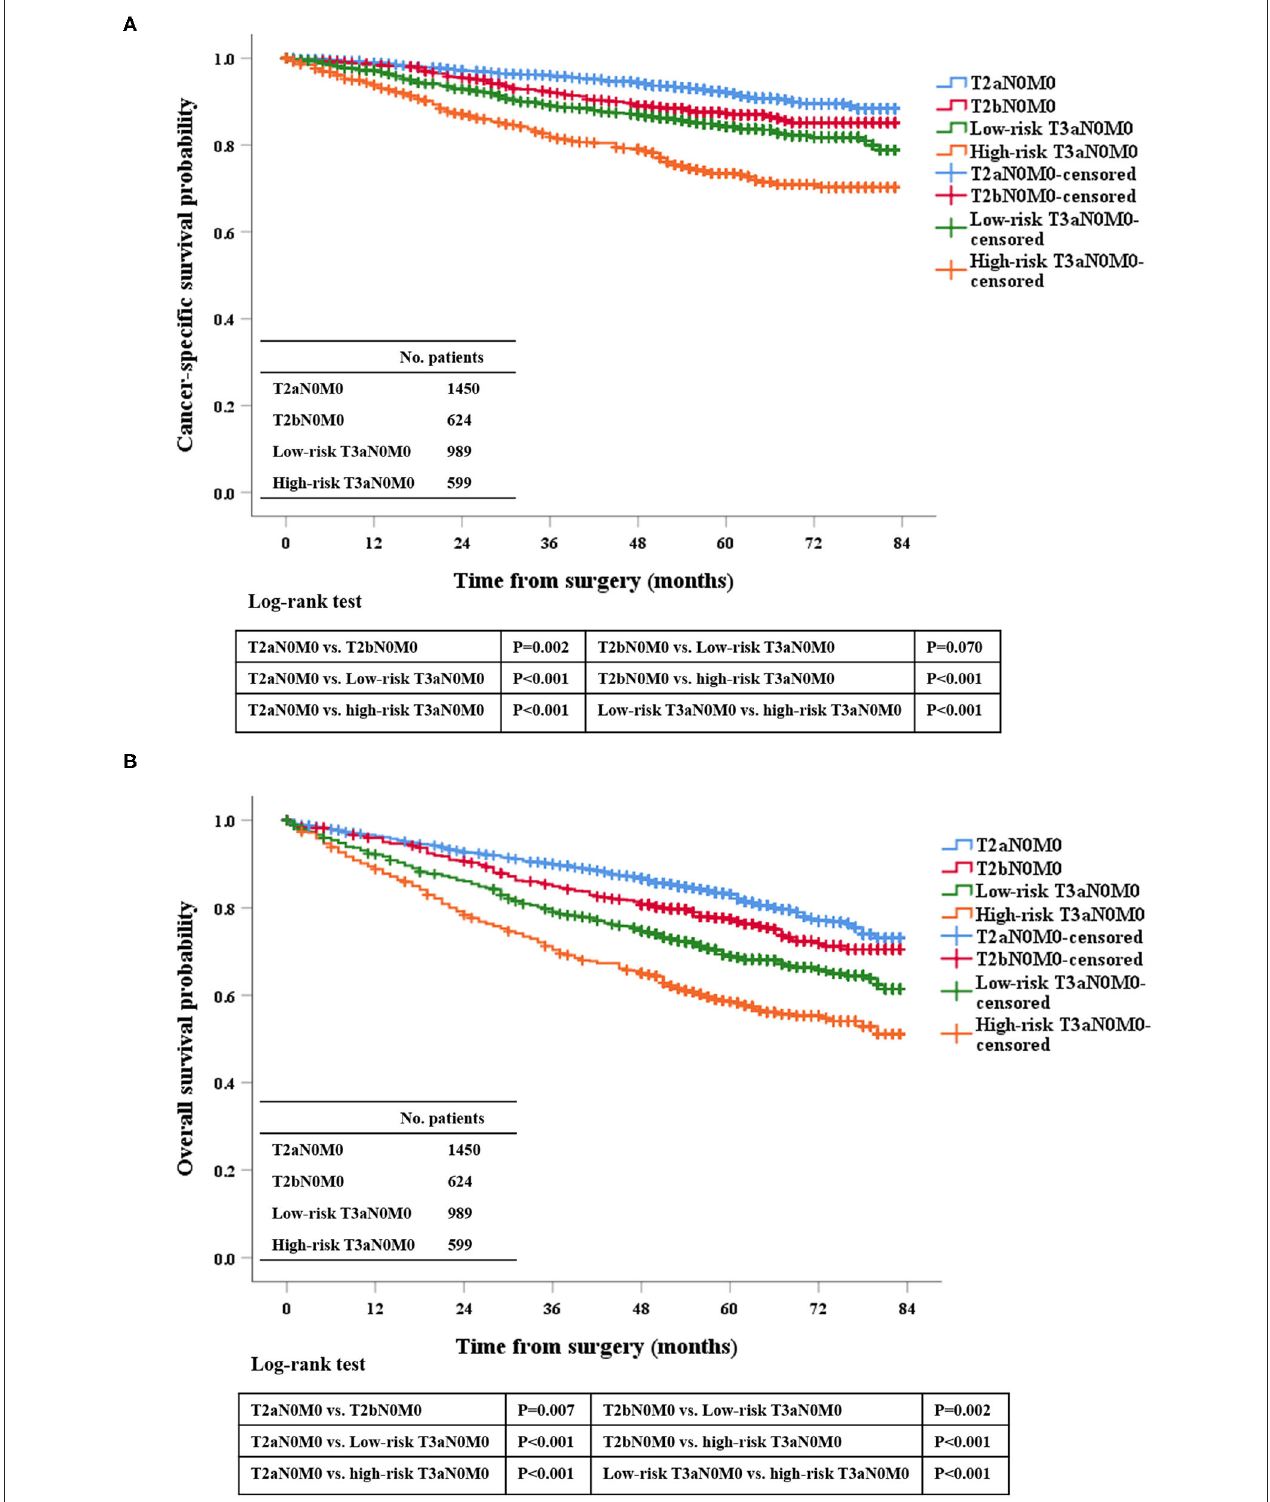
FIGURE 1 | Kaplan-Meier survival estimates for patients with pT2aN0M0, pT2bN0M0, low-risk pT3aN0M0, and high-risk pT3aN0M0 RCC who underwent radical surgery for CSS (A) and OS (B) .